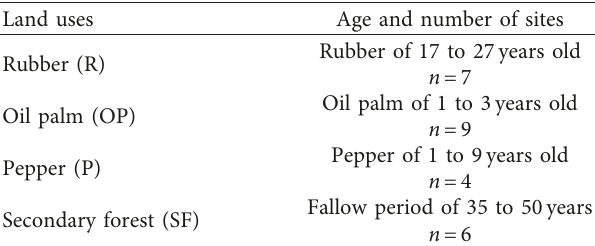
Table 1: Information on the selected study